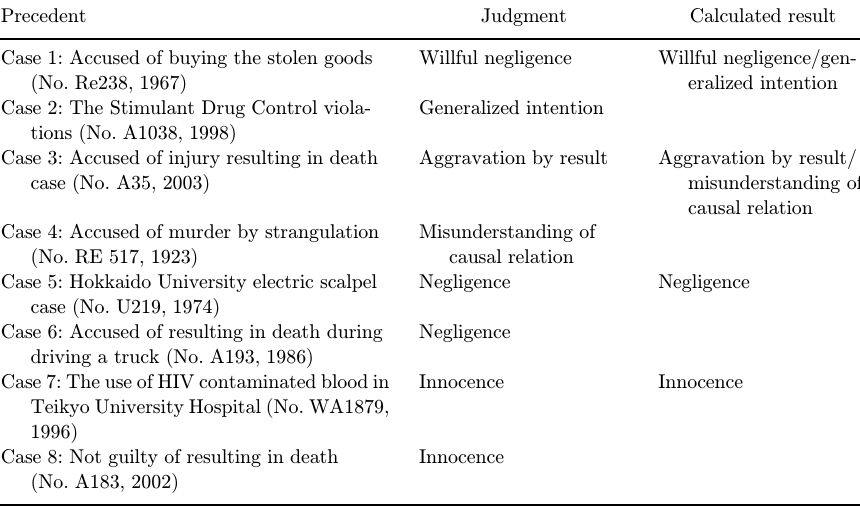
Table 5. Comparison of the calculations with the